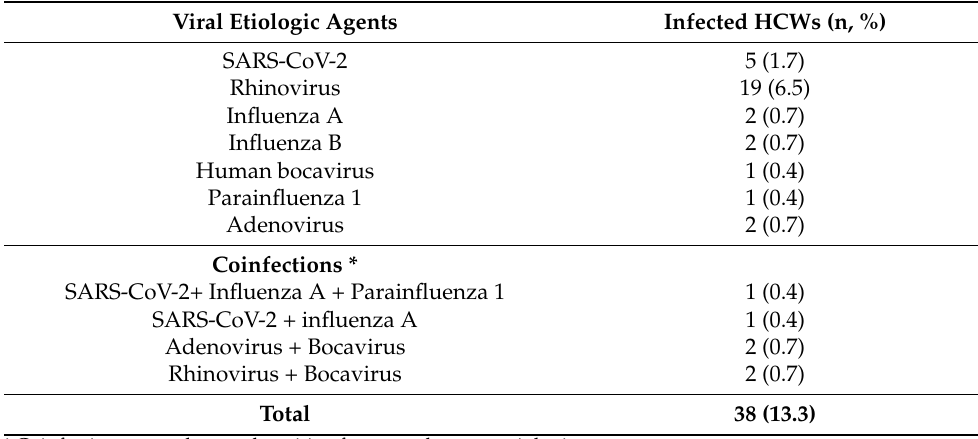
Table 1. Summary of the positive test results of viral panels (including SARS-CoV-2) tested among HCWs suspected of having COVID-19 and presented with URTI/LRTI-like symptoms, San Lazaro